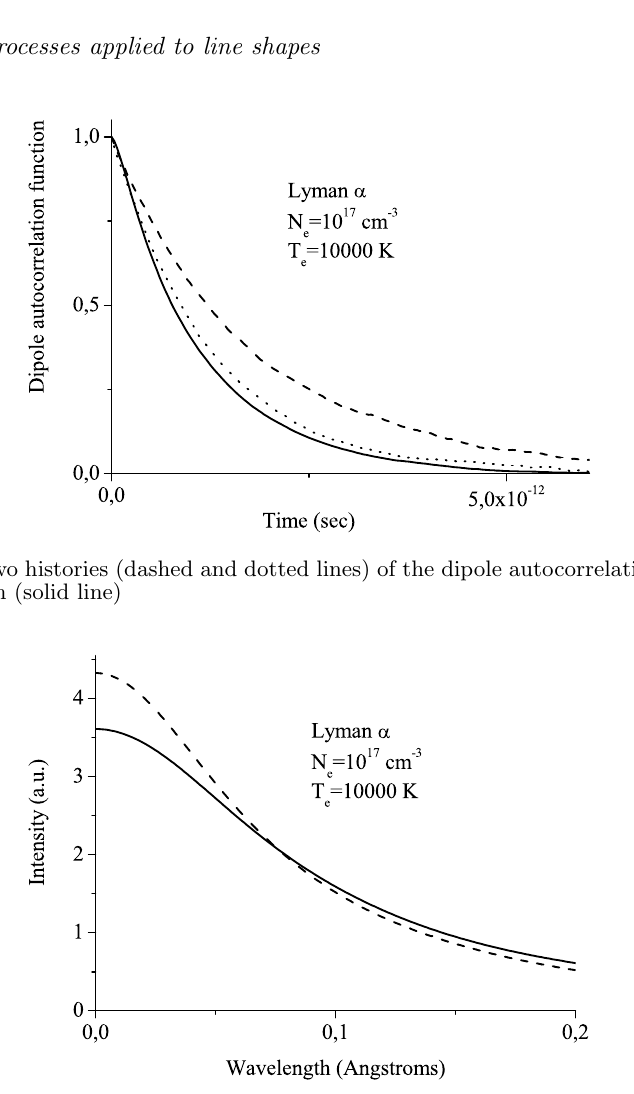
Fig. 3. Dipole autocorrelation function for ions only: comparison of an ab initio simulation (solid line) with our MMM calculation using the original jumping frequency v ( t j E ) (dashed line), and this frequency times a factor 2.2 (dotted